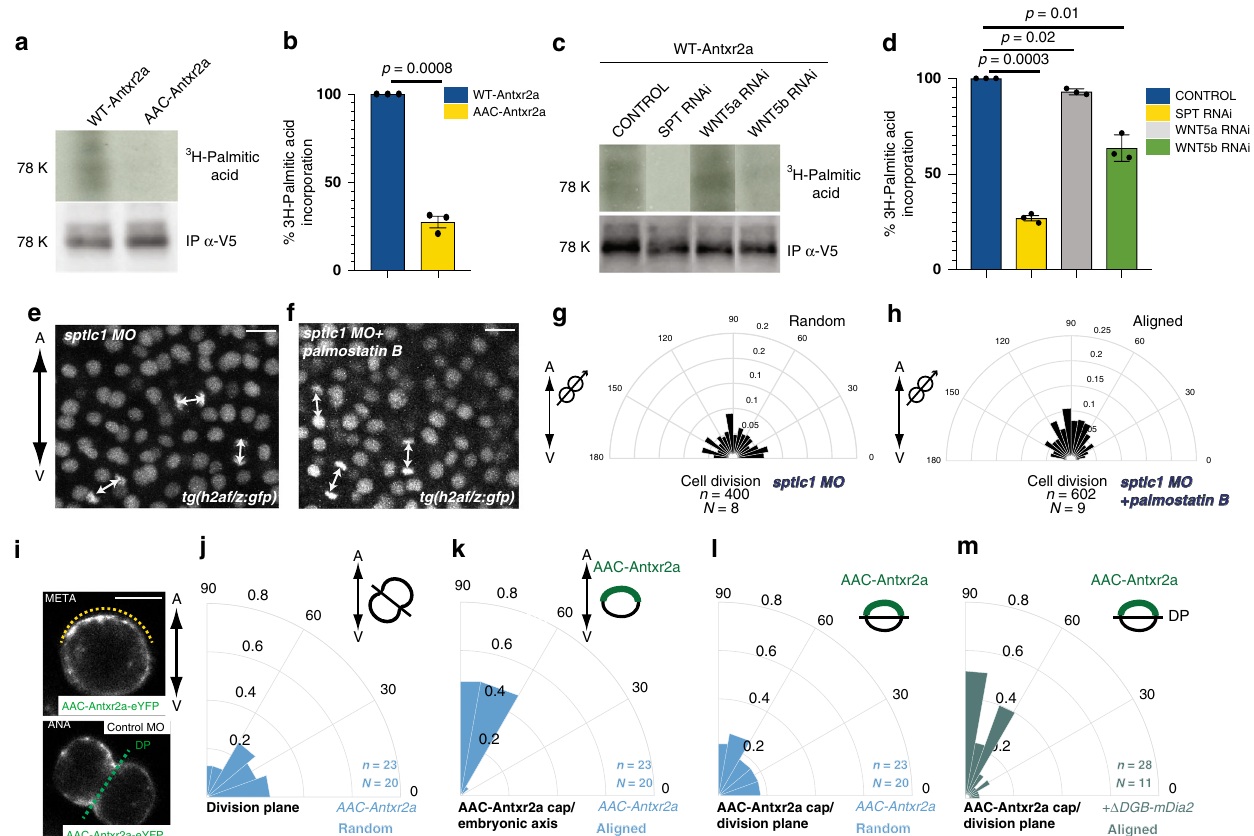
Fig. 7 Sphingolipids regulate Antxr2a palmitoylation to control oriented divisions. a , c 3 H-palmitate incorporation assay. Representative blots showing 3 H-palmitate levels incorporated into WT-zAntxr2 or AAC-zAntxr2a expressed in HeLa cells ( a ) or into WT-zAntxr2a expressed in either Control, SPT, WNT5a or WNT5b RNAi HeLa cells ( c ). b , d Quanti fi cation of 3 H-palmitate incorporation as shown in ( a , c ), normalized to the average of incorporation in WT-zAntxr2a from three independent experiments. Silencing SPT or WNT5b results in a reduction of Antxr2a palmitoylation levels. WNT5a silencing causes a mild, but statistically signi fi cant effect on receptor palmitoylation. Data are represented as the mean value + / – SEM. Unpaired, two-tailed student ’ s t -test was used. e – h Division orientation of epiblast cells with respect to the A/V embryonic axis. e , f Representative confocal images of epiblast cells expressing H2A-GFP in sptlc1 morphants ( e ) or in sptlc1 morphants treated with palmostatin B ( f ) from at least eight independent experiments. Division axes are marked by arrows. Animal pole is up. Scale bars: 10 µ m. g , h Polar graphs showing the frequency distribution of the angle between the division axis and the A/V axis in sptlc1 morphants and sptlc1 morphants treated with palmostatin B. χ 2 test was used (see Supplementary Table 1). i Representative confocal images from a time-lapse movie of a dorsal epiblast cell at metaphase (META) and anaphase (ANA) expressing AAC-Antxr2a- eYFP in control morpholino-injected embryos. Yellow dashed line corresponds to AAC-Antxr2a cap. Green dashed line, division plane (DP). Embryos are oriented with the animal pole up. Embryonic axis is represented by a bi-directional arrow on the right. Scale bars: 10 µ m. j – m Polar graphs showing the frequency distribution of either the angle between the division plane (green dashed line in i ) and the A/V embryonic plane ( j ), the angle between the Antxr2a cap and the A/V embryonic axis ( k ) or the angle between the cap and the division plane of epiblast cells in live embryos expressing AAC-Antxr2a- eYFP ( l ) or expressing AAC-Antxr2a and Δ BDG-mDia2 ( m ). χ 2 test was used (see Supplementary Table 1). n (number of cells analyzed) over N (number of embryos). Source data are provided as a Source Data fi le. line embryos using either 2 ng of one of the two sptlc1 UTR MO, 0.5ng of the ATG injections 5 . pCS2-WT-Antxr2a-eYFP was used to generate the pCS2-AAC- MO or 0.5ng of the control MO. To knock down either wnt5a or wnt5b , 2ng of Antxr2a-eYFP using the QuikChange Site-directed kit from Stratagene (La Jolla, wnt5a MO (5 ′ -TCCACTTCAGCTTCAGCAGCATCAT-3 ′ ) 5,41 or 4 ng of wnt5b CA) according to the manufacture ’ s protocol with the following primers: Forward primer (AAC-Forward): 5 ′ -GGTCTTTAATAACGACAGTGGCGGCTAGAGG MO (5 ′ -GTCCTTGGTTCATTCTCACATCCAT-3 ′ ) 24 were used. CCAGAACCACCACATCA-3 ′ ; and Reverse primer (AAC-Reverse): 5 ′ -TGATGT To visualize F-actin, Antxr2a or AAC-Antxr2a, either 25pg of the biosensor GGTGGTTCTGGCCTCTAGCCGCCACTGTCGTTATTAAAGACC-3 ′ . lifeact-mRFP or 75 pg of antxr2a-eYFP or AAC-Antxr2a-eYFP mRNAs were Zebra fi sh Sptlc1 complementary DNA (cDNA) was obtained from Dharmacon injected into one cell of 16-cell stage, wild type or sptlc1 (ATG MO) morphant (Catalog number: MDR1734-202793948). This cDNA was cloned into pCS2 + embryos. F-actin, Antxr2a or AAC-Antxr2a cap formation was monitored by 3D vector using the following primers: confocal imaging in embryos at shield stage (6hpf at 28 °C). Forward primer (sptlc1-Forward): 5 ′ -CGGAATTCATGGCGTCGGGGCAAC The sphingoid base sphinganine was obtained from Avanti Polar Lipids AGTG-3 ′ ; and Reverse primer (sptlc1-Reverse): 5 ′ -CCGCTCGAGTCATTTCA (Alabaster, Alabama, USA). Ten micromolar stock solution was prepared in GGACGTGTAAAG-3 ′ containing an Eco RI and Xho I restriction sites. ethanol. For the rescue experiment of oriented cell division, 0.5 nl of a 1:40 dilution Three non-overlapping morpholinos, two against the 5 ′ -UTR sequence of the was injected into sptlc1 or wnt5b morphant embryos or in embryos expressing zebra fi sh sptlc1 gene (sptlc1-1-UTR MO: 5 ′ -GCGACTTCCTGATTGATAAAGA AAC-Antxr2a-eYFP. GGC-3 ′ ; sptlc1-2-UTR MO: 5 ′ -CGCCATTTTGACTGAGTCACATGAT-3 ′ , and The palmostatin B was obtained from Sigma-Aldrich (Reference #178501). Tg another against the coding sequence (sptlc1-ATG MO: 5 ′ -ACCCACTGTTGC ( h2afva:h2afva-GFP ) embryos injected with sptlc1 MO were developed until CCCGACGCCATTT-3 ′ ) (Gene Tools, Inc.) were used to knock down sptlc1 in blastula stage. Then, embryos were incubated with 100 μ M for 4h, dechorionated zebra fi sh embryos. As a control morpholino, we used a 3-nucleotide mismatch of by hand and imaged as described below. For the measurements of the length of the the ATG MO. Experiments were carried out by injecting 1-cell stage, wild-type AB body axis in sptlc1 morphant embryos treated with palmostatin B, the fi sh medium 10 NATURE COMMUNICATIONS| (2020) 11:3317